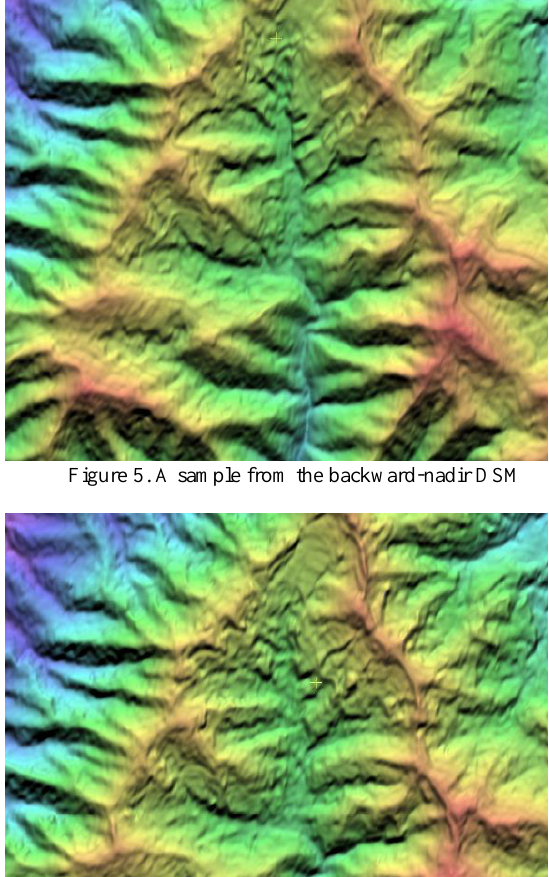
Table 2. RMS of accuracy (elevation in meters) when comparing the results from each stereo pair with a reference